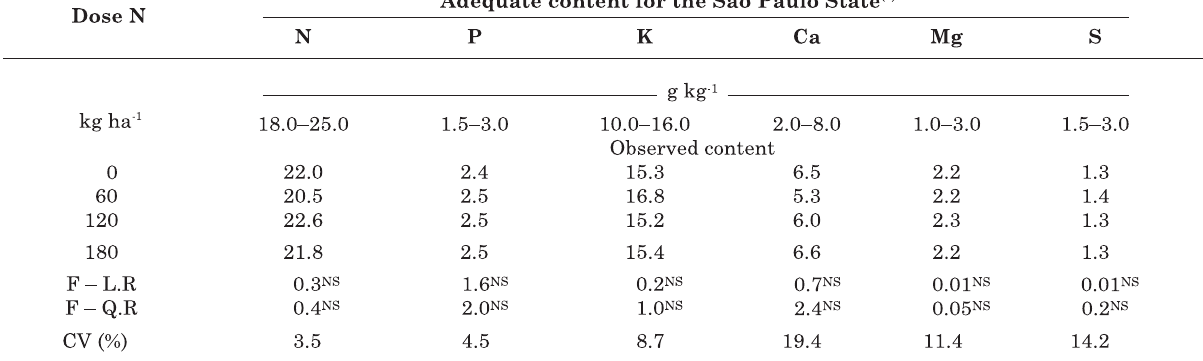
Table 3. Concentration of macronutrients from the leaf diagnosis of sugarcane (third ratoon) 60 d.a.f. in relation to the doses of ammonium chloride-N applied on the second